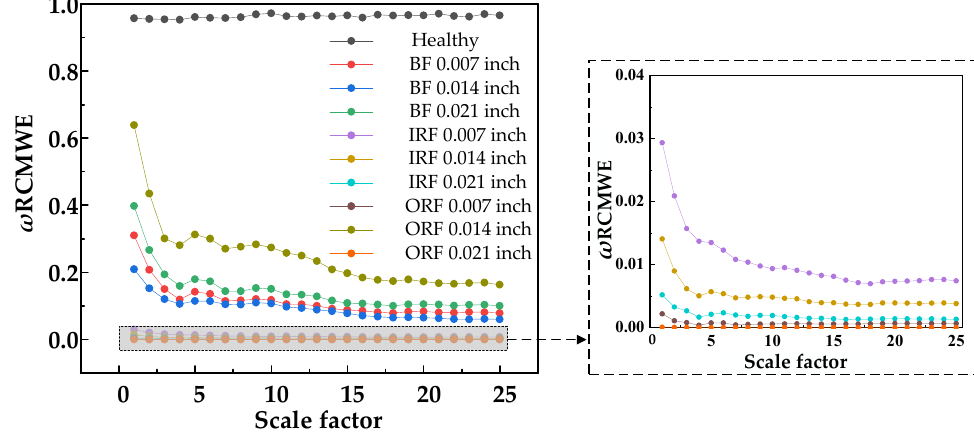
Figure 15. γ RCMDE entropy values of 25 scale factors under different damage degrees.